Question: Sum up the contents of this chart in one sentence.
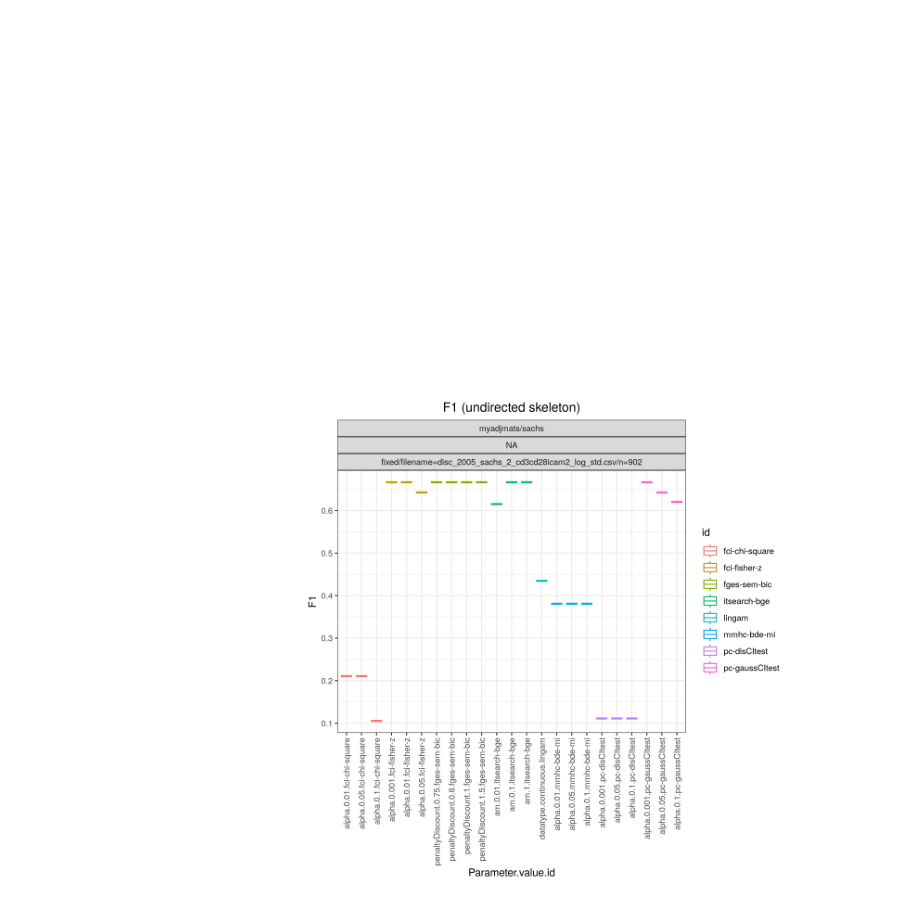
Answer: F1 Scores on the Sachs data set. Discretized, no noise.